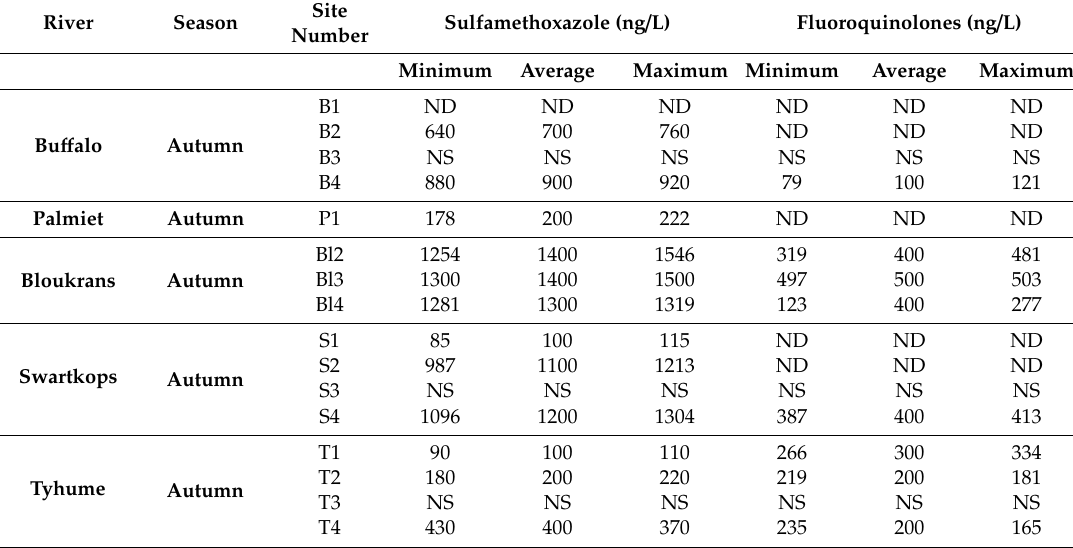
Table 4. Concentration of sulfamethoxazole and fluoroquinolones of Bu ff alo, Bloukrans, Swartkops and Tyhume River water samples detected by enzyme-linked immunosorbent assay (ELISA) screening during the autumn